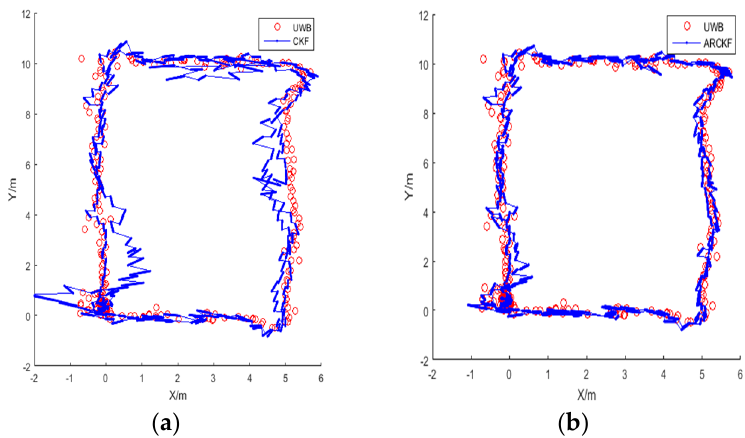
Figure 11. Positioning result for Route 1: ( a ) the standard CKF; ( b ) the proposed ARCKF.